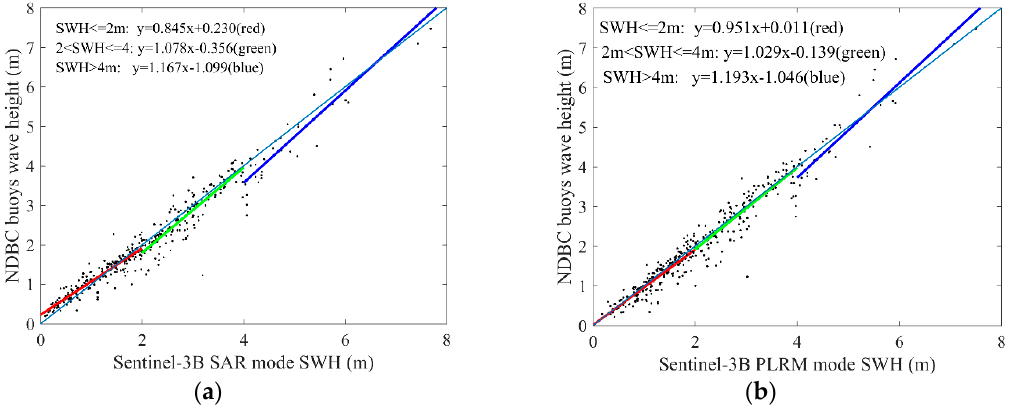
Figure 19. Calibration results of Sentinel-3B SAR ( a ) and PLRM ( b ) mode SWH data.